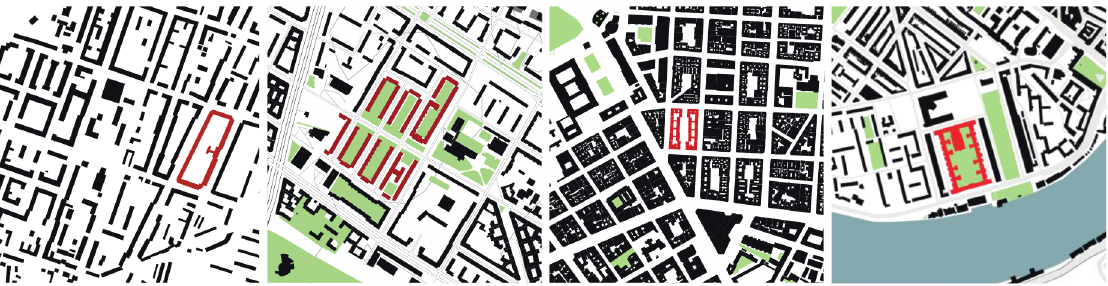
Figure 5. Drawings of the Elemente der Stadtarchitektur course at Potsdam School of Architecture, winter